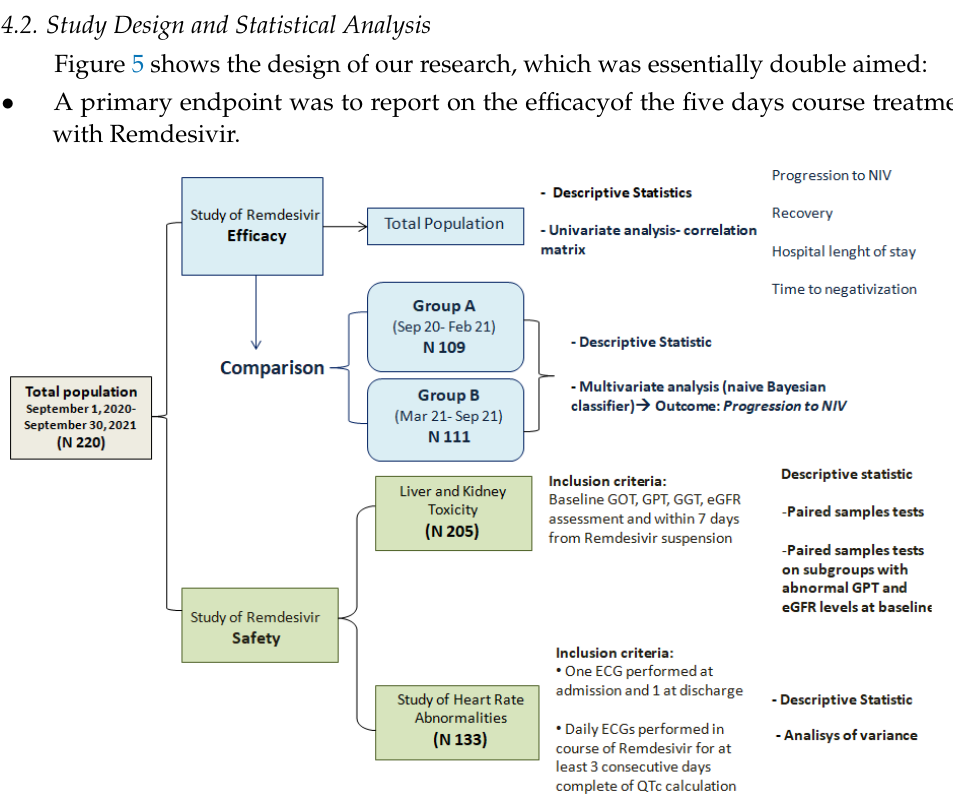
Figure 5. Flow-chart illustrating study design.